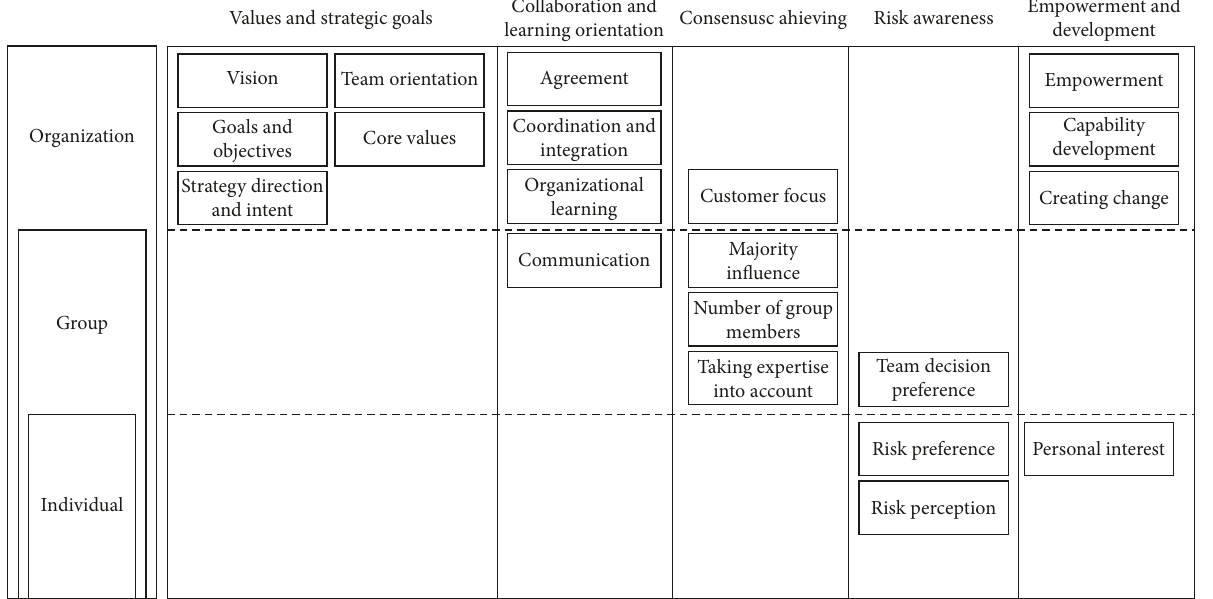
Figure 1: The system of factors on three-organizational levels influencing group